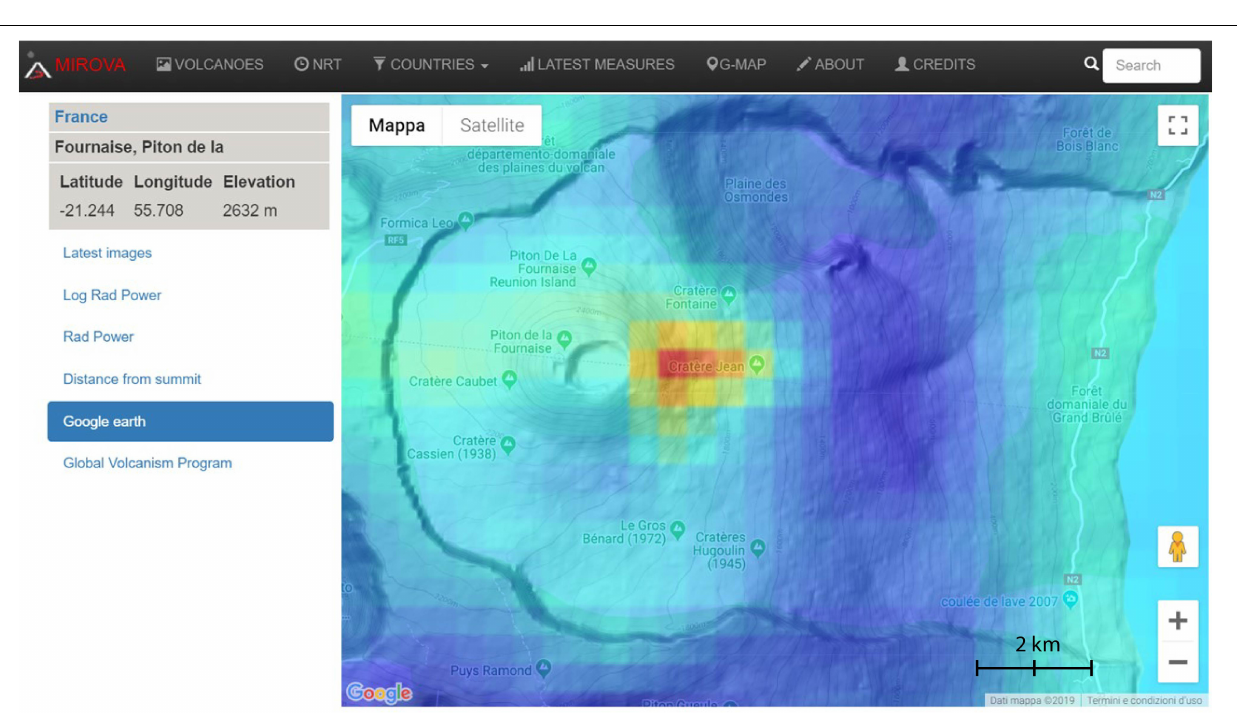
FIGURE 5 | Snapshot of the Google Map’s overlay posted on MIROVA website for the Piton de la Fournaise volcano, La Réunion Island (accessed on 14 June 2019). The overlay image represents the Brightness Temperature (BT) recorded by MODIS in the MIR channel, resampled to a spatial resolution of 500 m. Yellow to red pixels indicate higher BT values associated to the presence of a cooling lava flow on the upper eastern flank of the volcano.